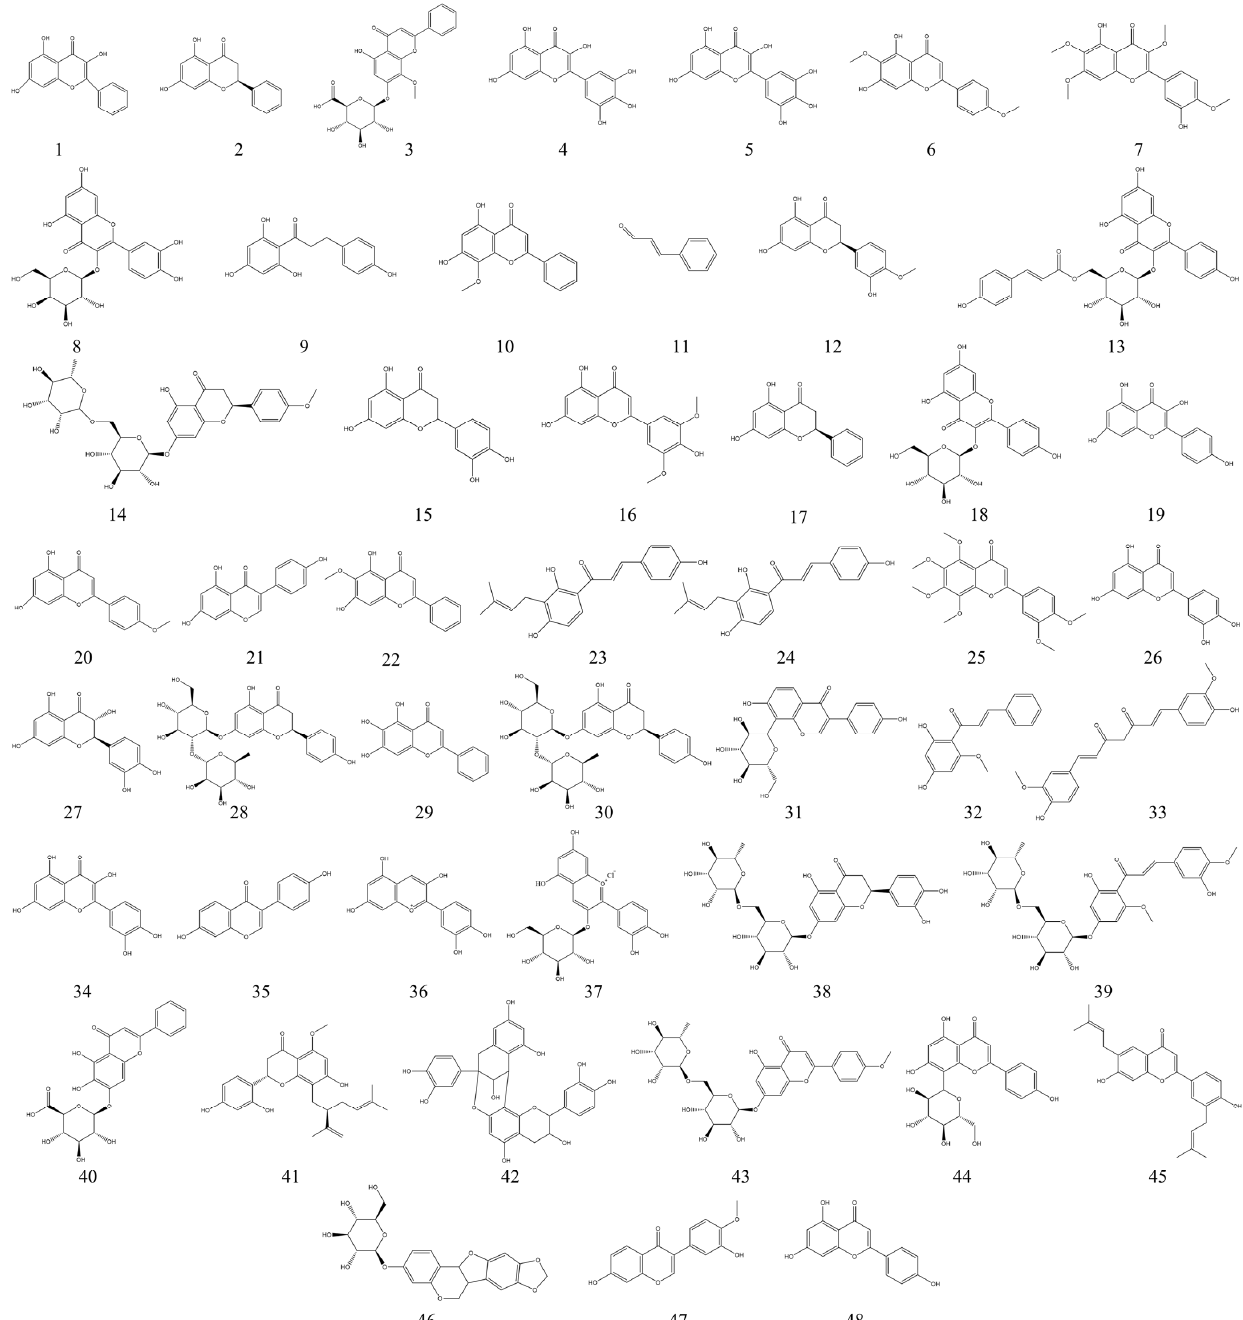
Figure 4. Structural formulae of flavonoids with IBD therapeutic effects.